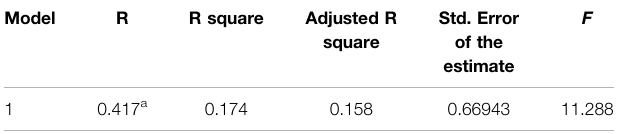
TABLE 3 | Case A: H2. Regression model